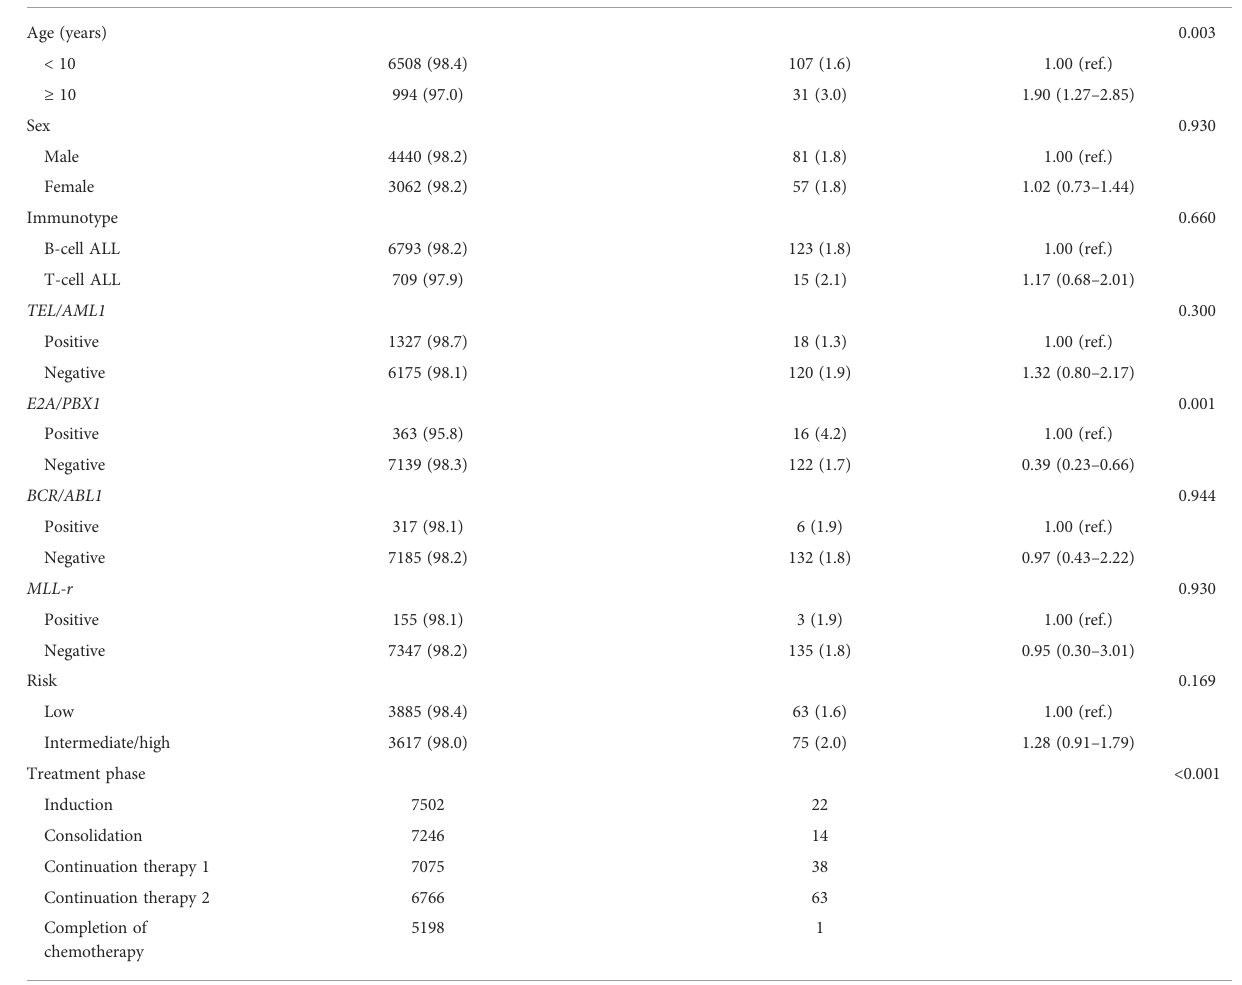
TABLE 1 Characteristics of children with acute lymphoblastic leukemia, with and without and varicella-zoster virus infection.